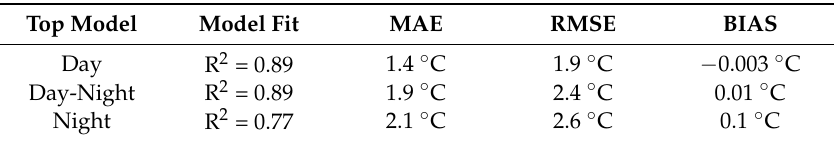
Figure 6. In situ understory temperatures vs. predicted T ust values estimated using the top-ranked models for ( a ) day and night; ( b ) daytime; and ( c ) night. These validation data were collected during clear-sky MODIS overpasses within a nearly-deciduous (6% conifer) observation plot with moderate canopy closure (60%) at an elevation of 1330 m. Table 6. Comprehensive results of the top-ranked T ust models. Coefficient of determination (R 2 ), mean absolute error (MAE), root mean square error